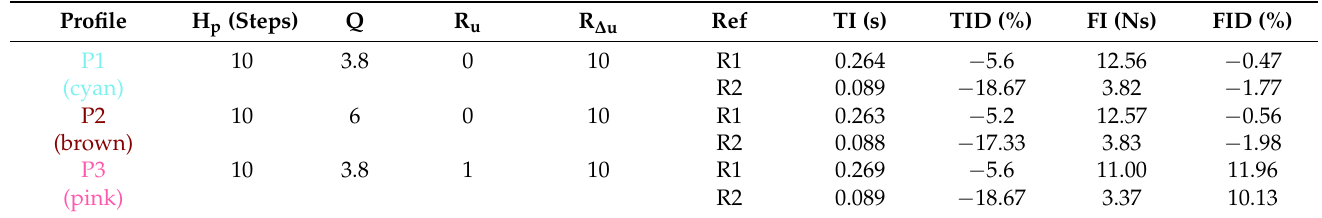
Figure 4. Force tracking of the MPC algorithm for the MIL: ( a ) refers to the R1 reference signal (50 N, 250 ms), ( b ) refers to the R2 reference signal (50 N, 75 ms). Reference force signal in red dashed lines, continuous lines refer to the output contact force obtained for different control parameters (see Table 4). Table 4. MIL MPC tuned parameters and the resulting performance indices. The labels and colors refer to the corresponding curves presented in Figure 4.